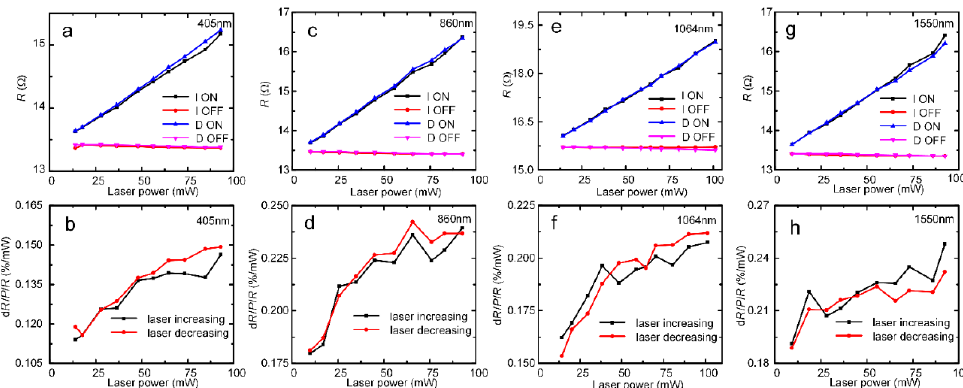
Figure 5. The R - P curves of the CNT–MoS 2 composite network under laser irradiation at different wavelengths: ( a ) 405 nm; ( c ) 860 nm; ( e ) 1064 nm; ( g ) 1550 nm. The relative resistive responsivity per mW of power d R /( P ∙ R ) curves under laser irradiation at different wavelength: ( b ) 405 nm; ( d ) 860 nm; ( f ) 1064 nm; ( h ) 1550 nm.